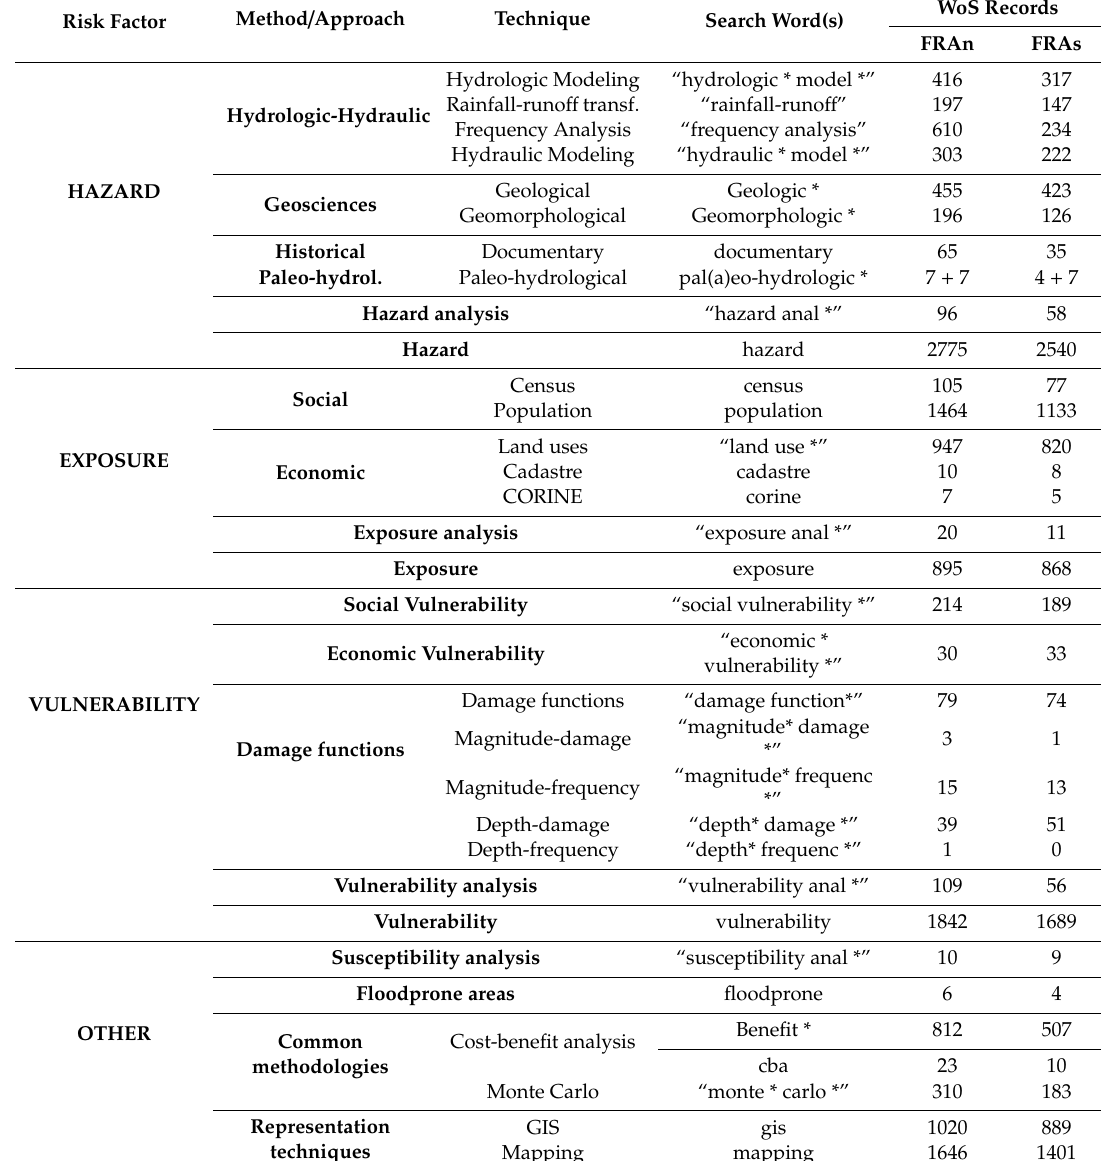
Table 4. Number of records in the Web of Science (WoS) database regarding di ff erent methods, approaches and techniques of “flood risk analysis and assessment”. The asterisk (*) is a commonly used wildcard symbol that broadens a search by finding words that start with the same letters. Searched